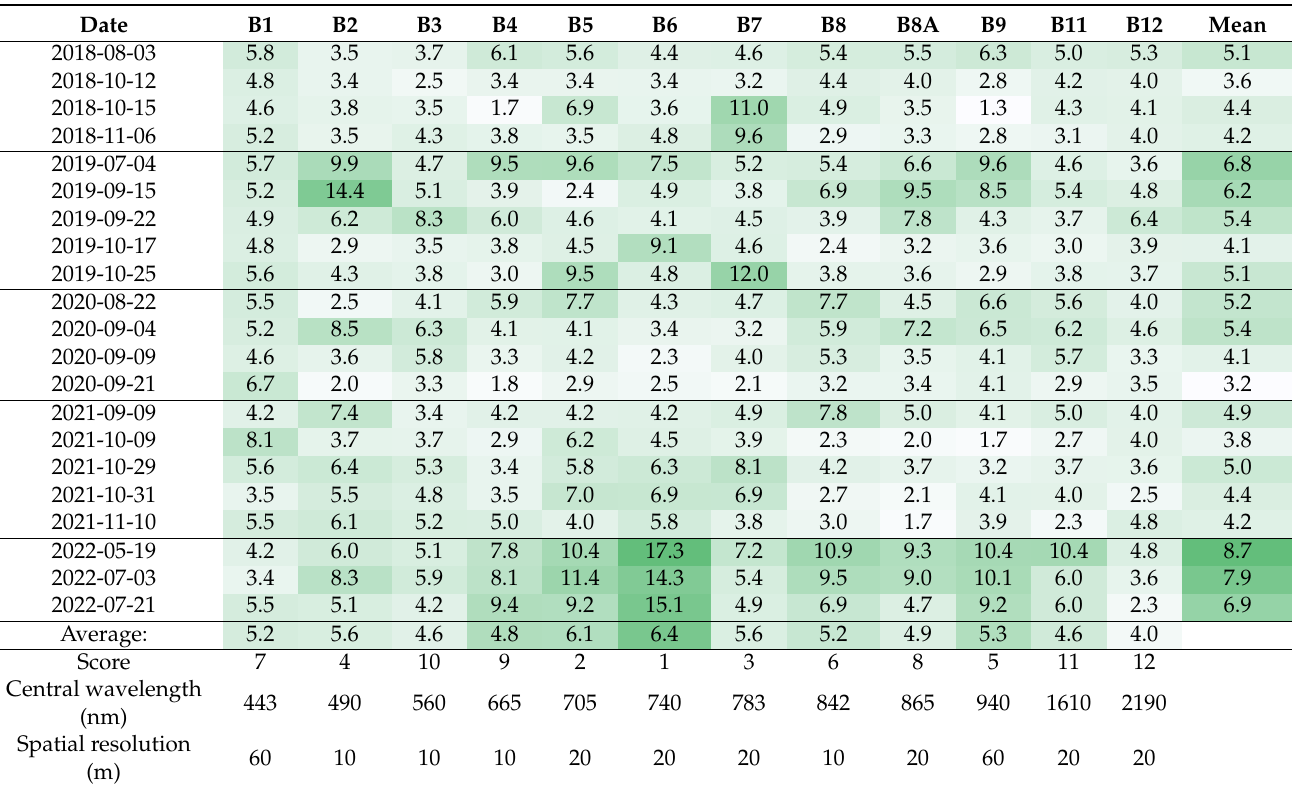
Table 4. Relationship of variable importance (mean decrease in accuracy) between Sentinel-2 bands and acquisition dates (values for topographic features; DEM: 54.8; slope: 12.7; aspect: 5.4). The importance of the bands was confirmed by the intensity of the green